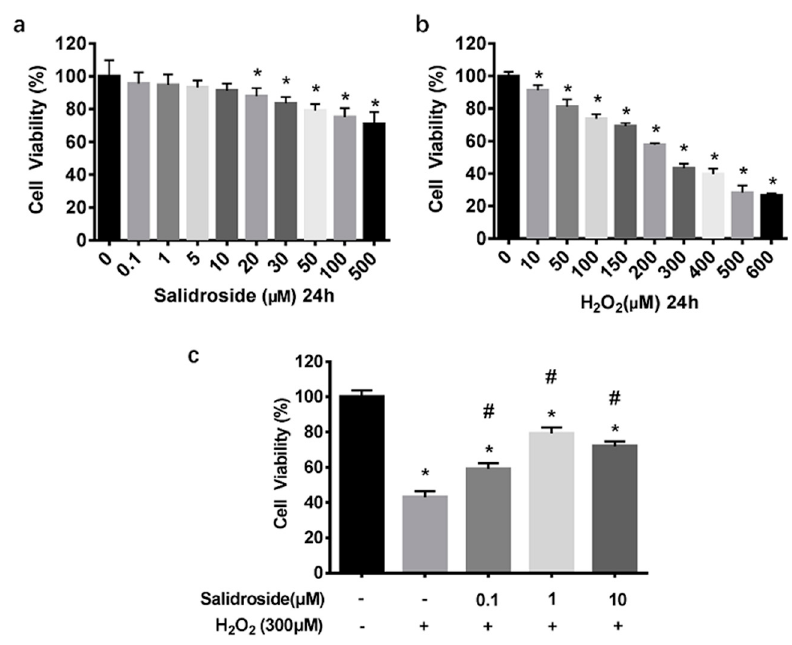
Figure 2. SAL prevents H 2 O 2 -induced cell injury. Cell viability was determined by MTT assay, and the viability of untreated HUVECs was taken as 100%. ( a ) HUVECs were incubated with SAL (0.1–500 μ M) for 24 h. ( b ) HUVECs were treated with various concentrations of H 2 O 2 (0–600 μ M) for 24 h. ( c ) HUVECs were treated with SAL (0.1, 1, 10 μ M) for 24 h before being treated with H 2 O 2 (300 μ M) for another 24 h. Data are presented as mean ± SD values of three independent experiments. * p < 0.05 vs. control. # p < 0.05 vs. H 2 O 2 -treated HUVECs.